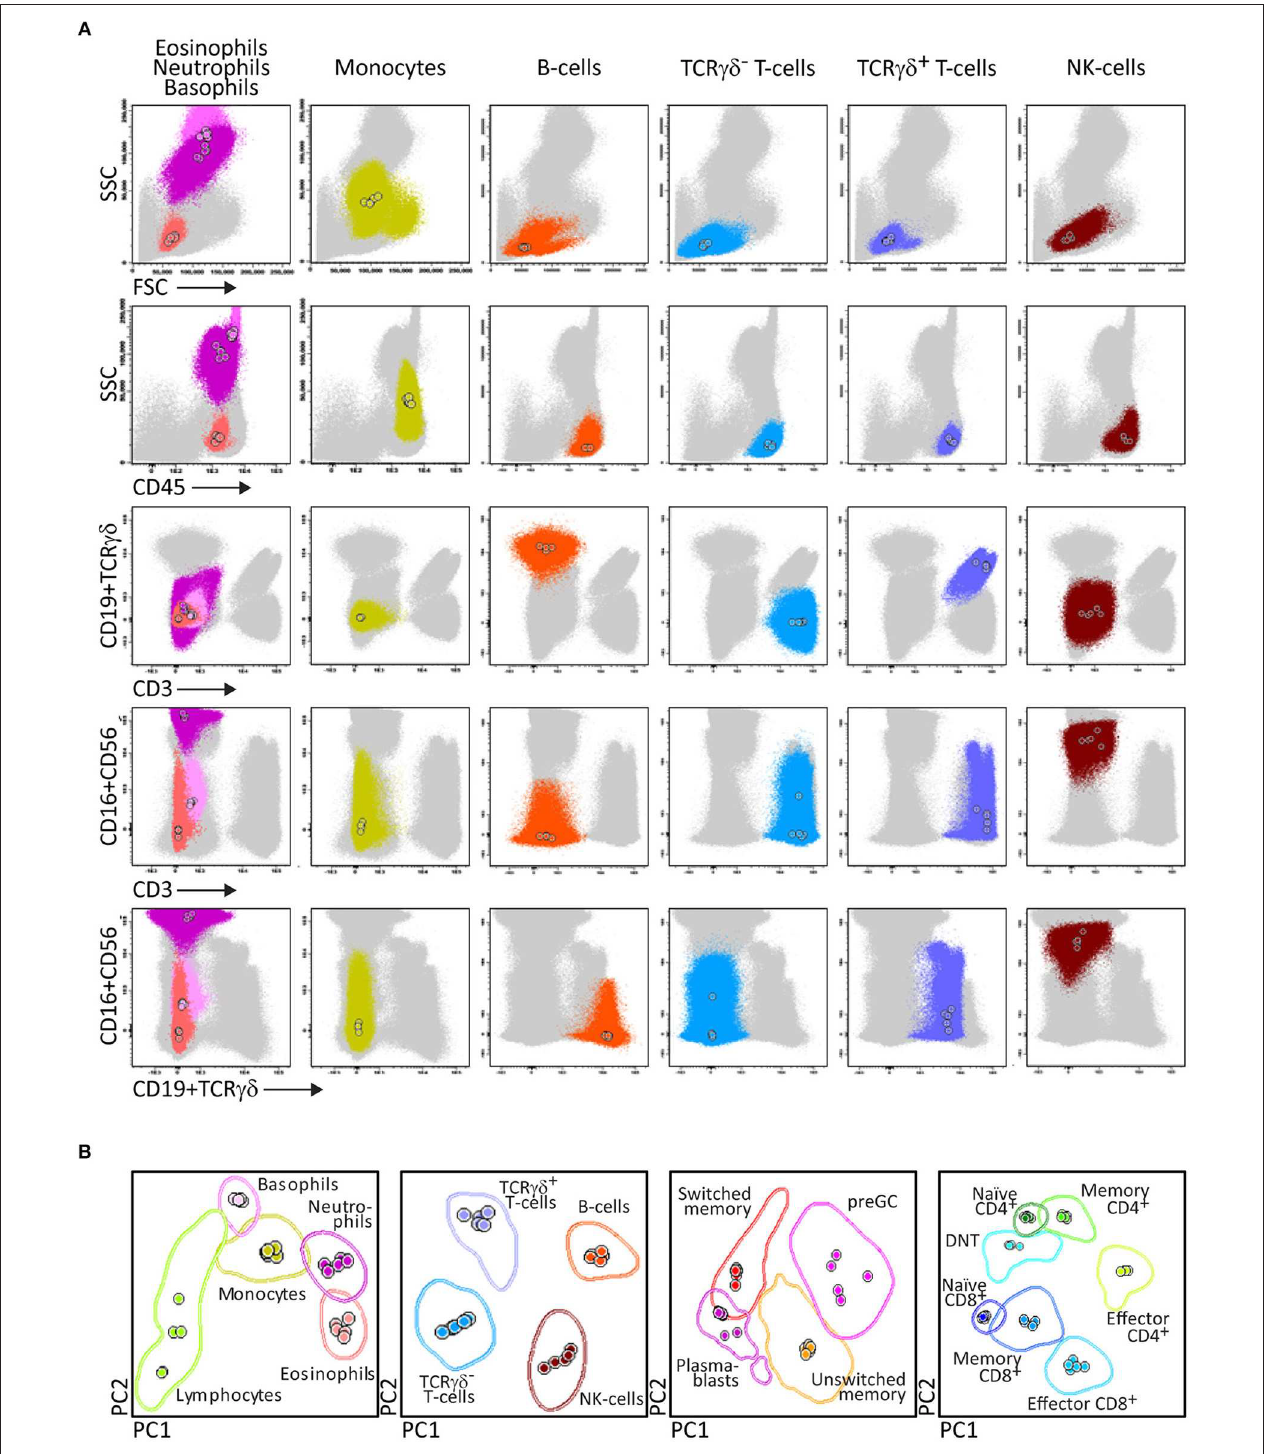
FIGURE 2 | Generation of a reference principal component analysis 1 (PCA1) vs. PCA2 representation in an n-dimensional space for discrimination of the lymphocytes subsets identified with PIDOT. (A) Data files from 5 healthy donors were merged and lymphocyte subsets of interest identified using bivariate plots. (B) The merged data were used to define an n-dimensional space with the best principal component analysis 1 (PC1) vs. PC2 representation to discriminate these subsets. The PCA representation of the data is resumed in 2 × Standard Deviation (SD) curves to be used as a reference for supervised automatic analysis of the samples.